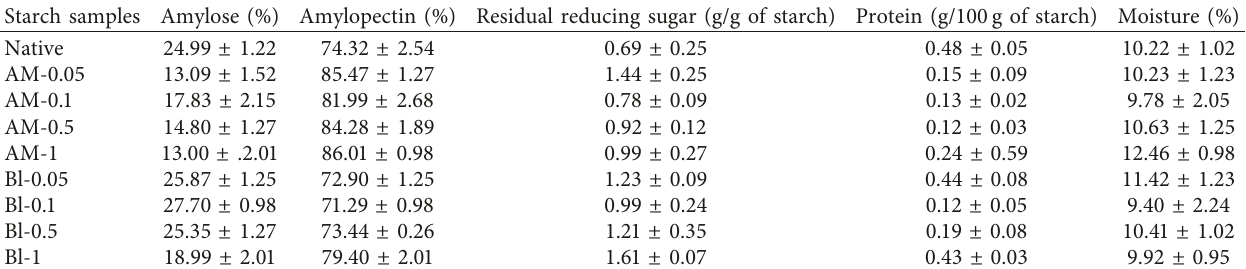
Table 2: Physical-chemical parameters of native and fermented modified potato starches. Starch samples Amylose (%) Amylopectin (%) Residual reducing sugar (g/g of starch) Protein (g/100 g of starch) Moisture